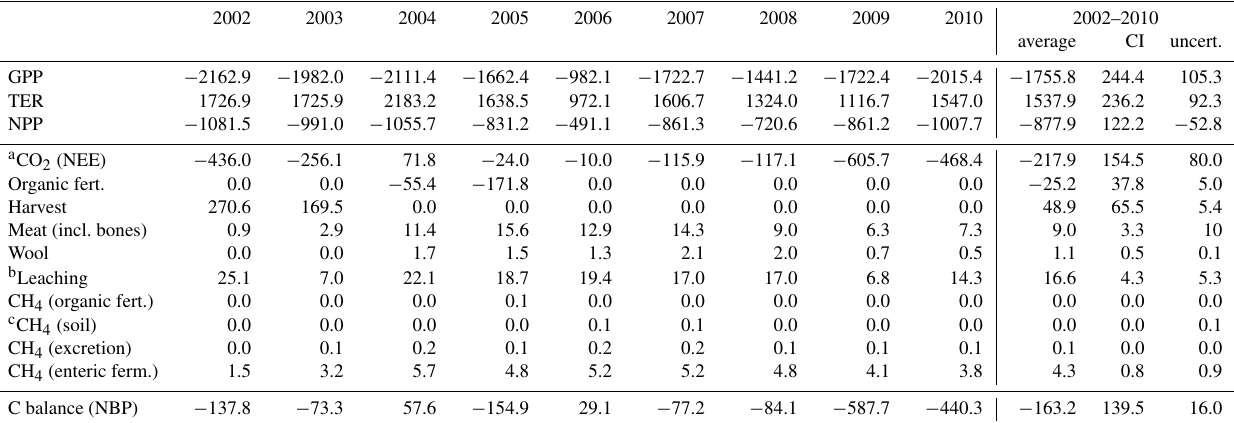
Figure 2. Mean annual nitrogen budget for Easter Bush, showing the fate of total N input (fertiliser and deposition) in (a) years when grass was harvested for silage (2002 and 2003) and (b) in years when only grazing took place (2004–2010). The residual term in (b) includes any net accumulation of soil organic nitrogen as well as all the error in the budget calculation. Table 4. Carbon budget and balance for each measurement year and average values, confidence intervals at p >0.95 (CI) and systematic uncertainties (uncert.) for 2002–2010 (gCm − 2 a − 1 ). Negative numbers represent uptake, while positive numbers represent loss of C from the grassland ecosystem. Letters indicate data published in previous